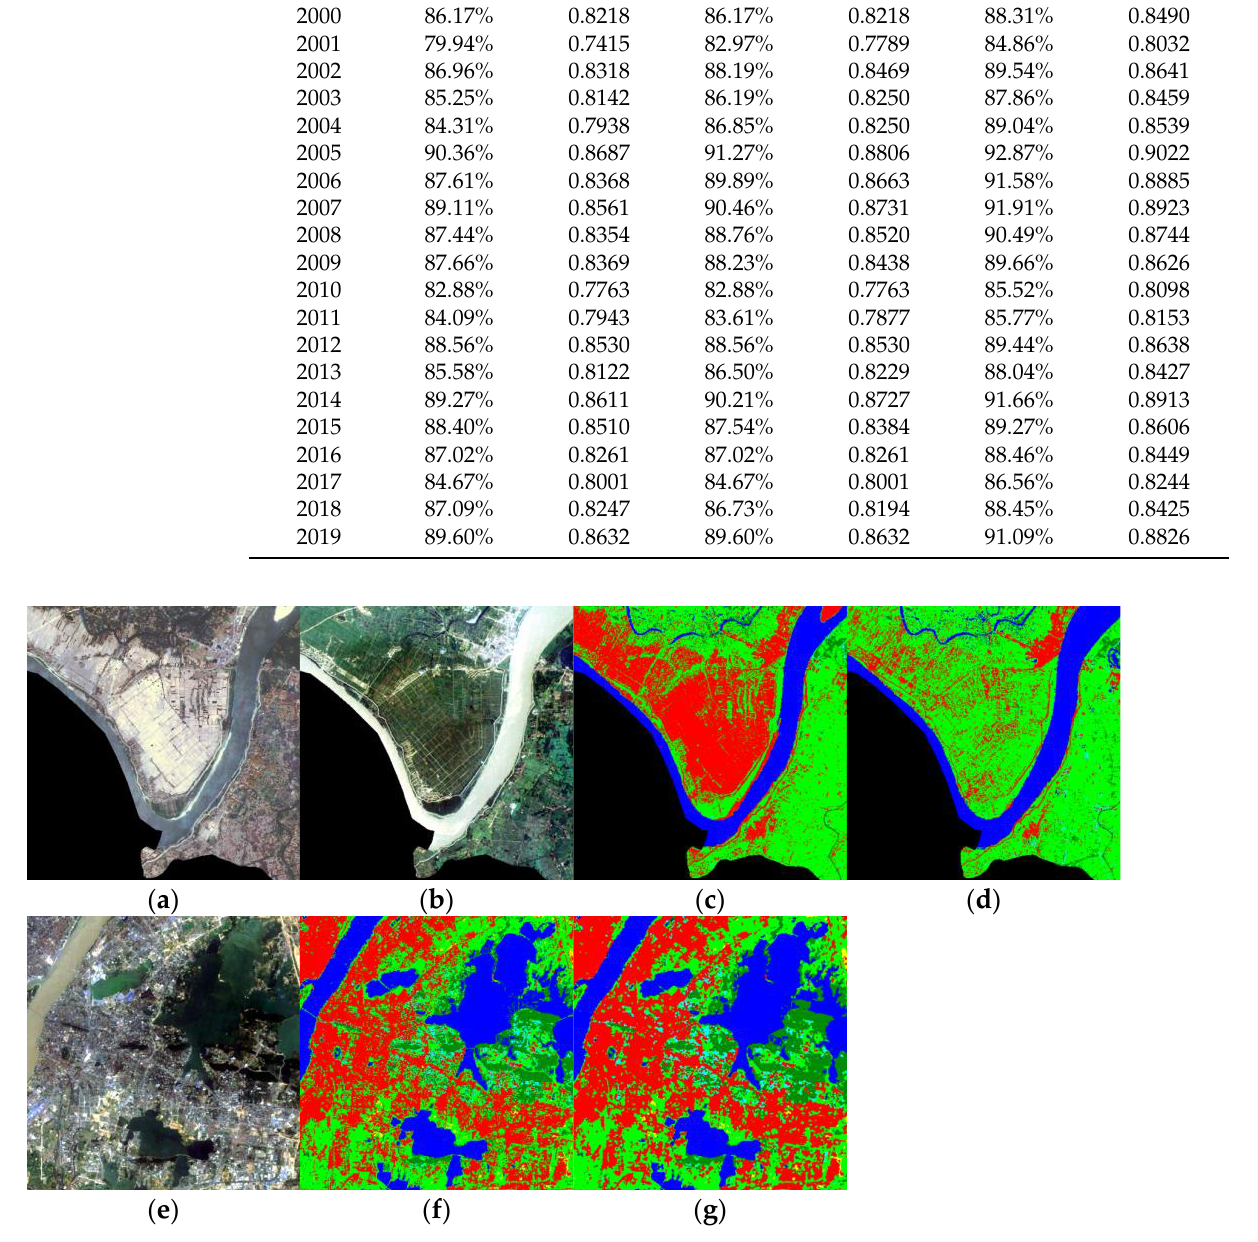
Figure 5. The post-processing on two typical scenes: ( a ) the false color image of scene 1 in 2006; ( b ) the false color image of scene 1 in 2007; ( c ) the LULC result before temporal consistency analysis; ( d ) the LULC result after temporal consistency analysis; ( e ) the false color image of scene 2 in 2009; ( f ) the LULC result before spatial coherence analysis; ( g ) the LULC result after spatial coherence analysis.